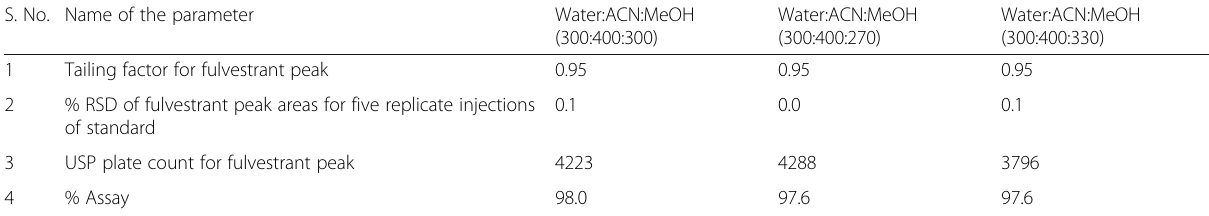
Table 9 Results of effect of variation in organic (methanol) variation S. No. Name of the